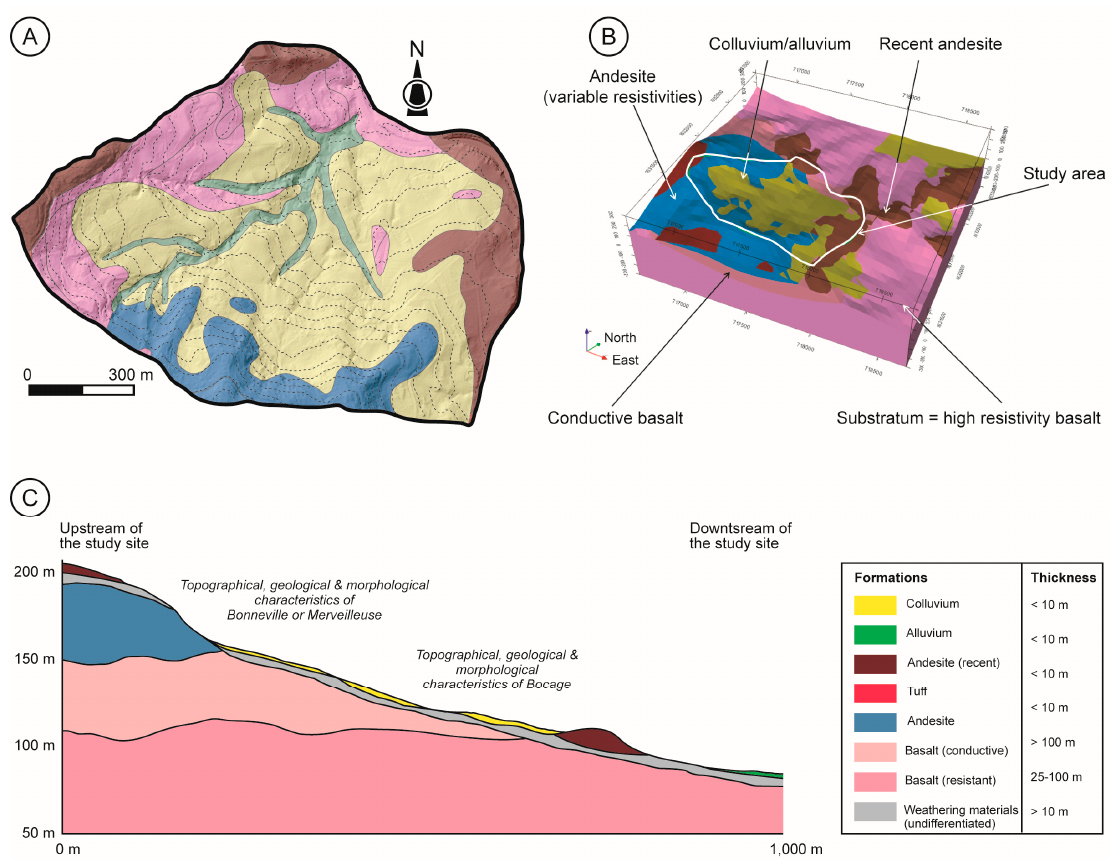
Figure 7. ( A ) Regolith map based on field survey and TDEM interpretations; ( B ) geological 3D model obtained from the GeoModeller ® ; ( C ) synthetic cross section of the test site obtained with ( A ) and ( B ).